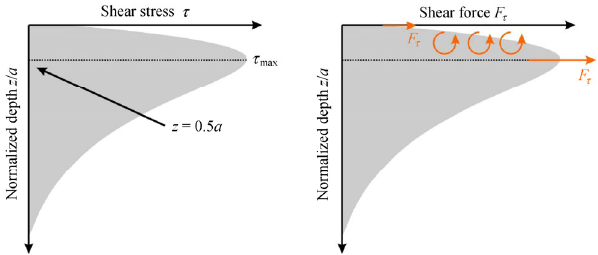
Fig. 11 Distribution of the shear stress and shear force throughout the depth of the contact region. The maximum value is located at a depth of approximately half of the Hertzian contact radius a .